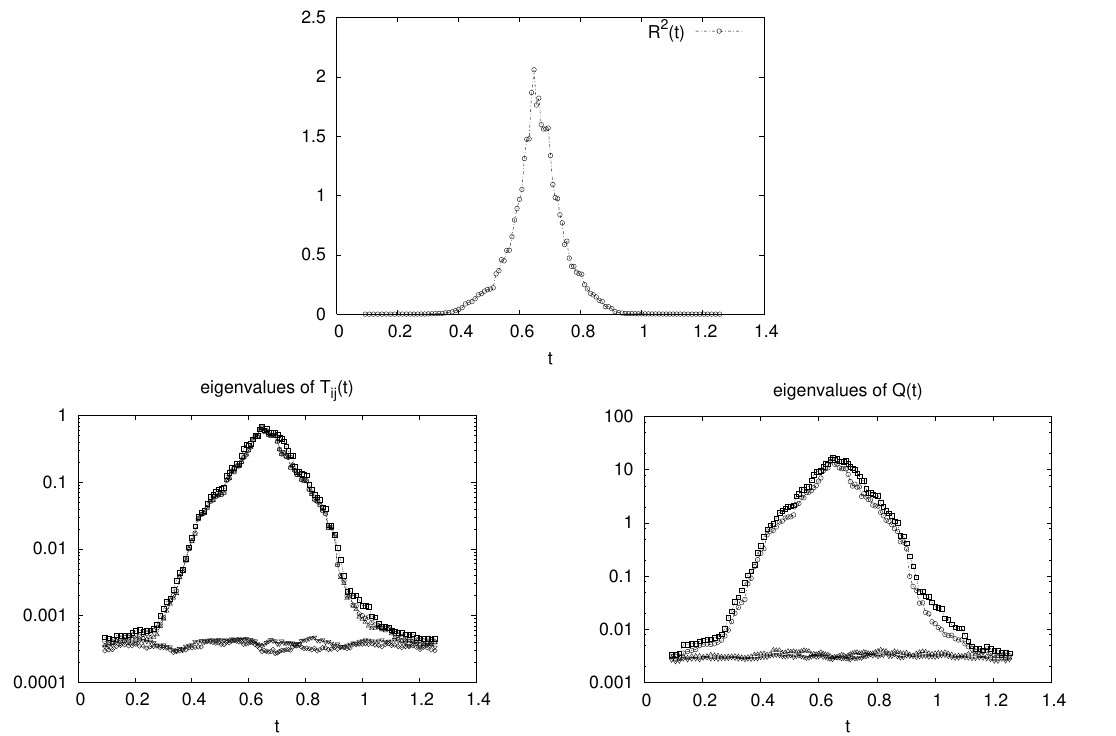
Figure 1 . Results for ( s, k ) = ( − 1 , 0), N = 128, κ = 0 . 13, β = 2, n = 16 are shown. (Top) The extent of space R 2 ( t ) is plotted against t . (Bottom-Left) The five eigenvalues of the moment of inertia tensor are plotted against t in the log scale. (Bottom-Right) The four largest eigenvalues of the matrix Q ( t ) are plotted against t in the log